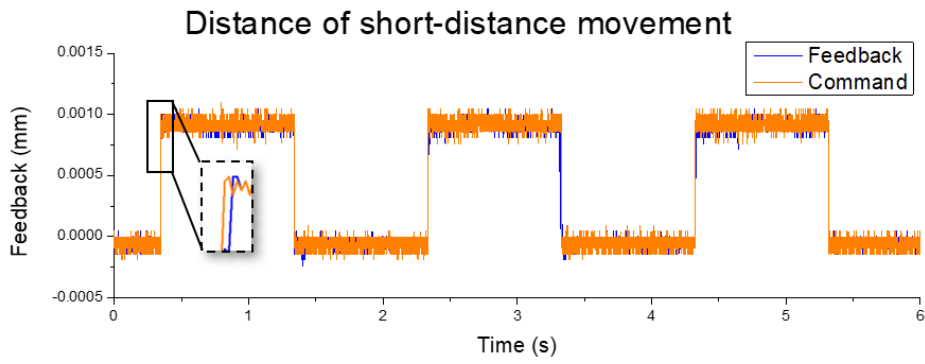
Figure 16. Position feedback measurement.